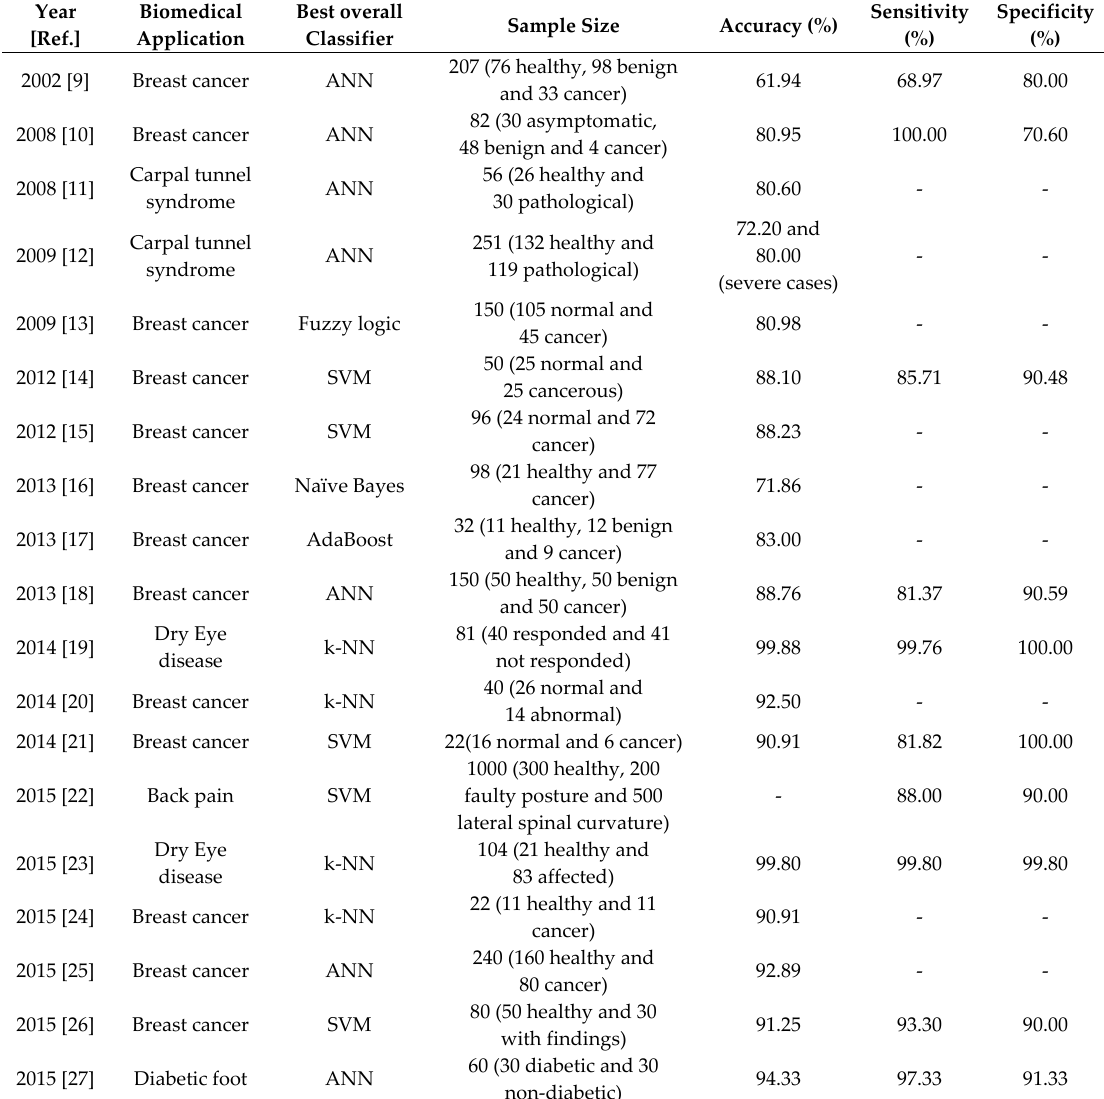
Table 1. The IRT imaging biomedical applications with machine learning